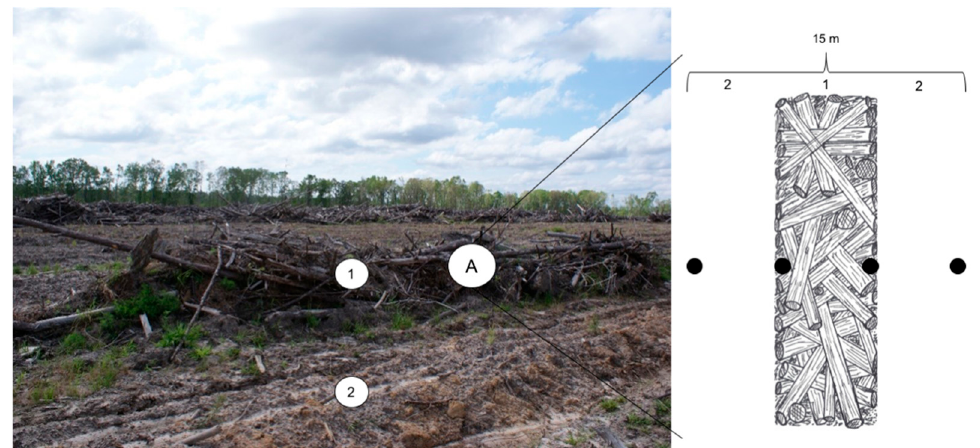
Figure 2. (A) Windrow in a clear-cut stand one-year post-harvest in Georgia. (1) Windrows were separated by (2) large expanses of bare ground. To accommodate the width of windrows, we set pitfall traps (black dots) 5 m apart, resulting in a total array length of 15 m. Two pitfall traps were situated immediately adjacently to either side of windrows, when present, and two pitfall traps were situated in bedded rows on either side of the windrow. Photo and drawing by Steve Grodsky.